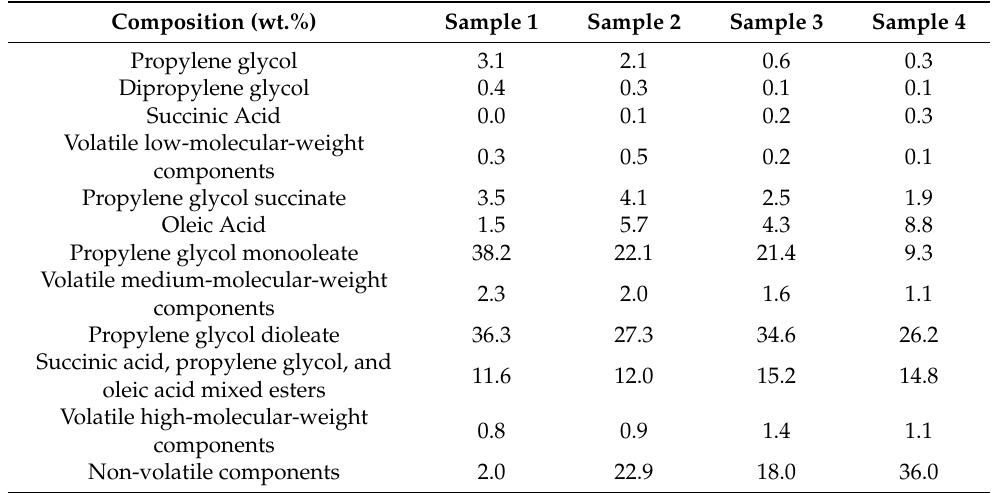
Table 4. Composition after the second step of plasticizer synthesis based on GC/MS and GC/FID. Composition